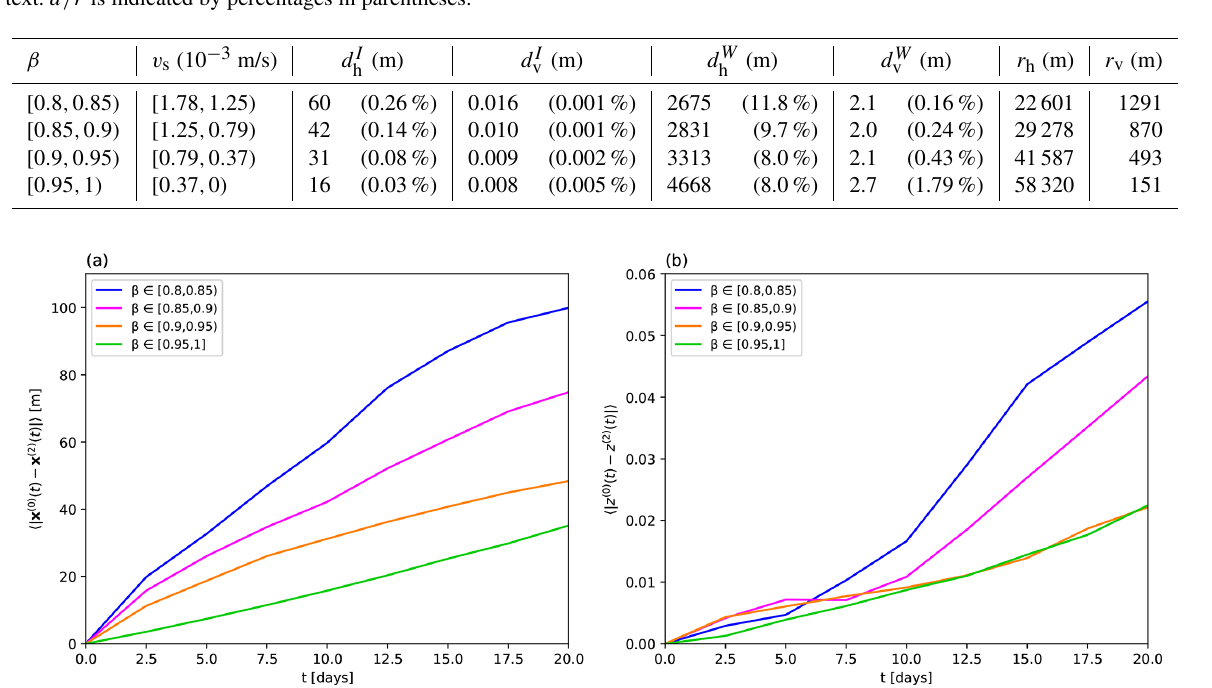
Table B1. Average horizontal and vertical pairwise particle distances d and single-particle displacements r after an integration time of 10d. See text. d/r is indicated by percentages in parentheses.